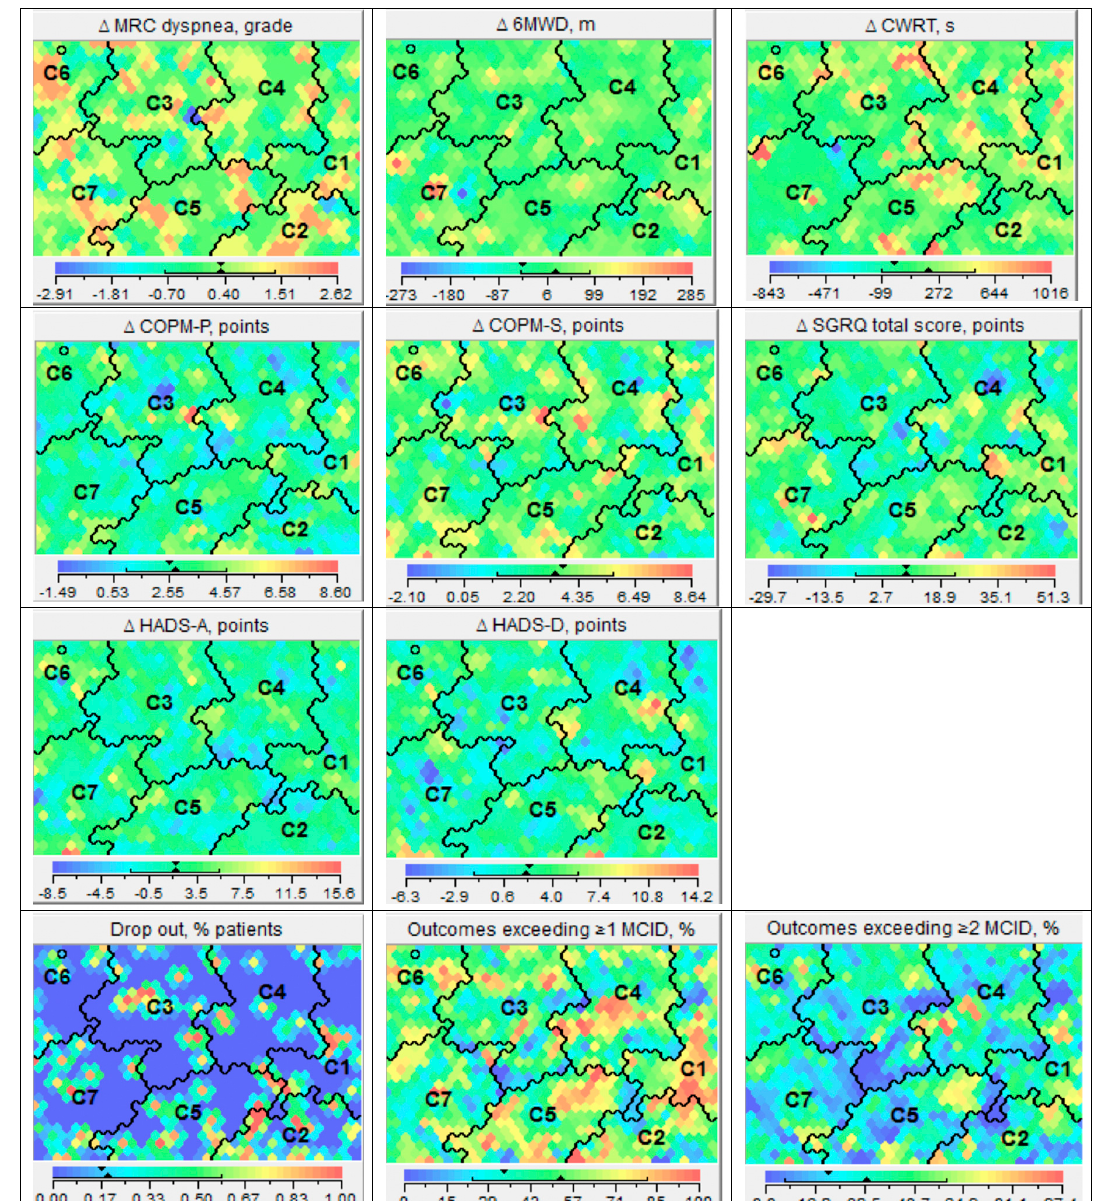
Figure 3. Changes following pulmonary rehabilitation. Different panels illustrating the absolute change in Medical Research Council (MRC) dyspnoea grade, 6-min walk distance (6MWD), cycle endurance time (constant work-rate test; CWRT), Canadian Occupational Performance Measure, Performance (COPM-P), Canadian Occupational Performance Measure, Satisfaction (COPM-S), Hospital Anxiety and Depression Scale, Anxiety (HADS-A), Hospital Anxiety and Depression Scale, Depression (HADS-D), and St. George’s Respiratory Questionnaire total score (SGRQ-T) for the seven lung function clusters. The other three panels demonstrate the proportion of patients not completing the pulmonary rehabilitation program, the proportion of clinically relevant outcomes (exceeding at least one minimal clinically important difference (MCID) and the proportion of clinically relevant outcomes (exceeding at least two MCID) for each lung function cluster.